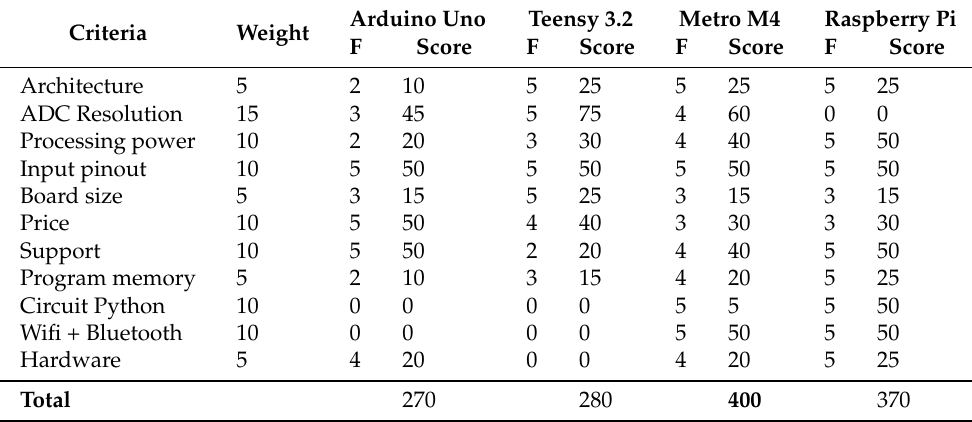
Table 3. Cost-benefit analysis for the microprocessor. Weight: Importance of each criterion (out of a total of 100); Factor (F): Evaluation of the sensor’s ability to meet this criterion; Score: Score achieved by the sensor for a given criterion. Score = Weight ∗ Factor. Bold value indicates the best score.